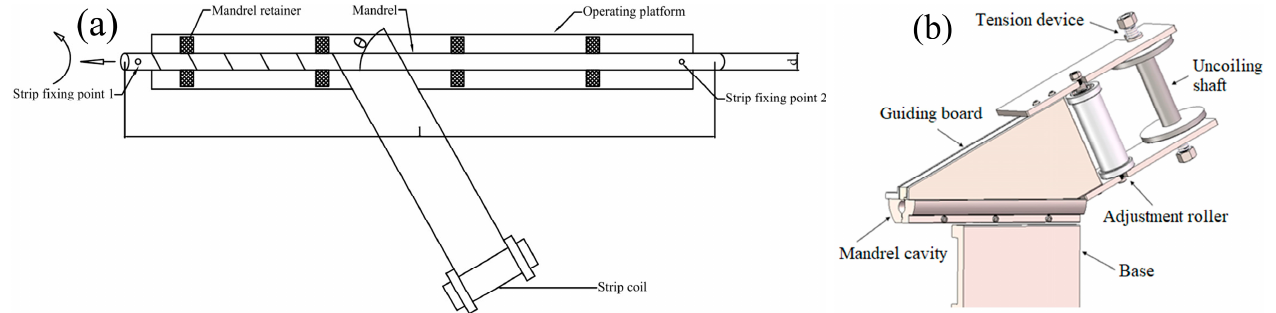
Figure 1. Schematic plot of STACER ( a ), the principle of the CSPB process ( b ), and its model diagram ( c ).